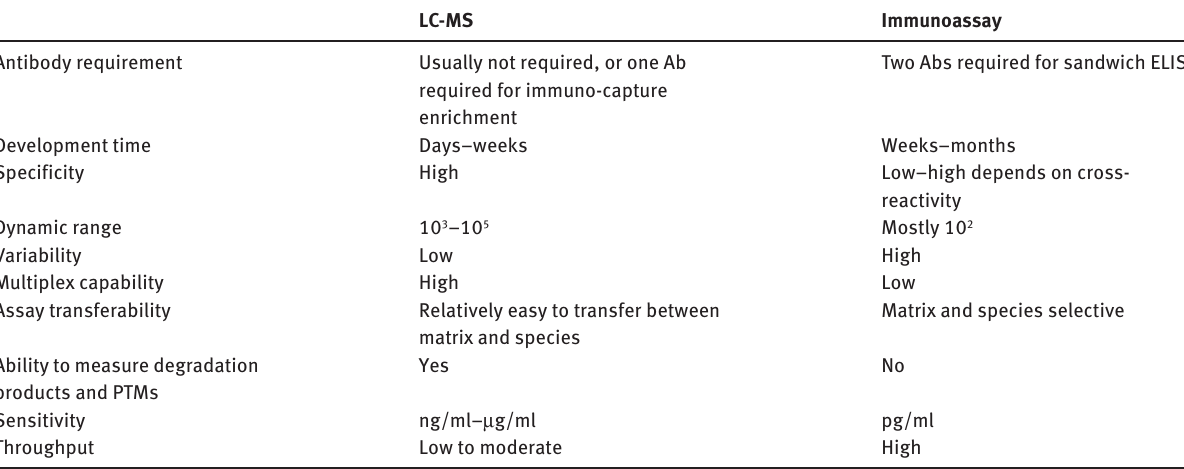
Table 1 Comparison of LC-MS and immunoassay for peptide and protein quantification.